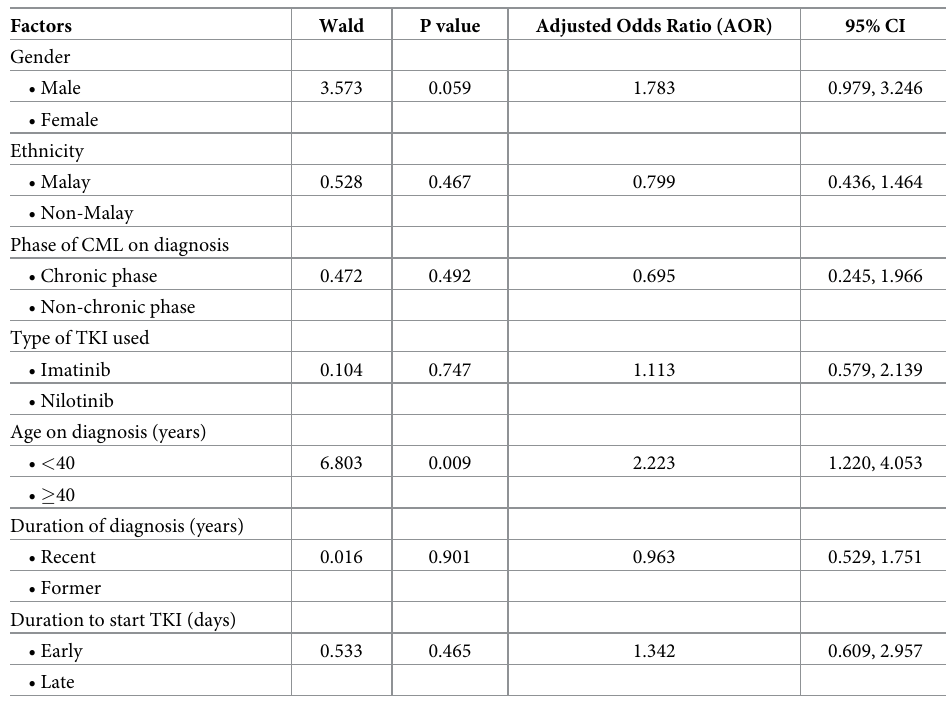
Table 3. Binary logistic regression analysis for determinants of CML HRQoL by EQ-5D.